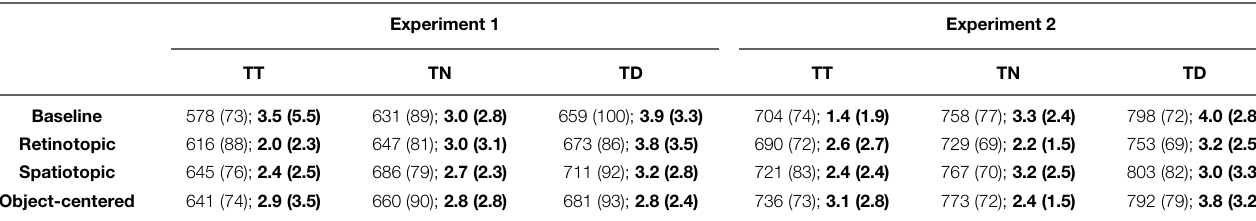
TABLE 2 | Mean reaction times (RTs ; in ms) and error rates (%) for trial n targets presented at trial n-1 target (TT), neutral (TN), or distractor (TD) locations, separately for the baseline, retinotopic, spatiotopic, and object-centered conditions in Experiments 1 and 2.